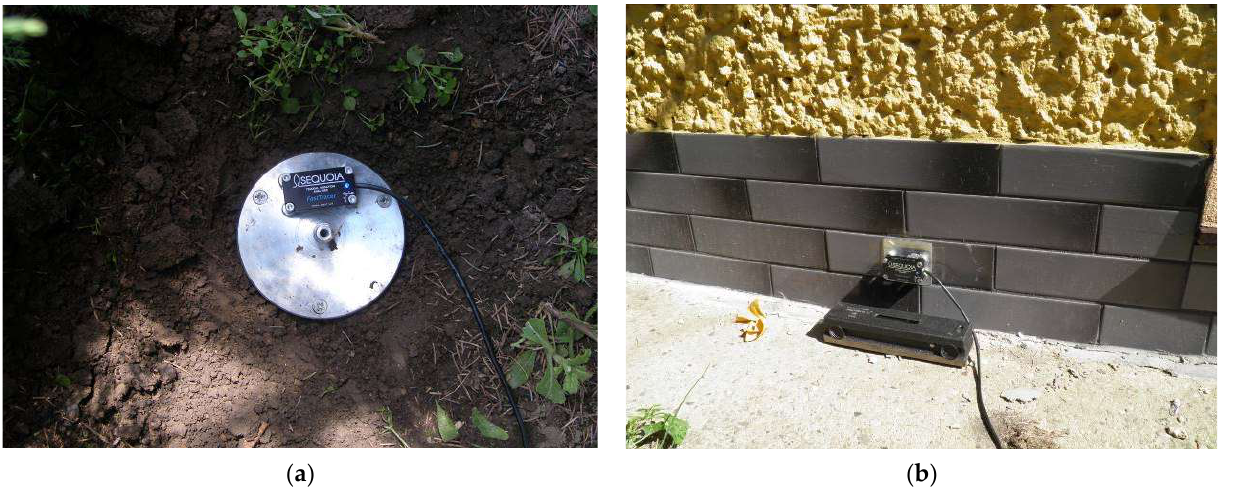
Figure 6. View on measuring points: ( a ) No. VII in soil, ( b ) No. I—situated on the outer wall of the building.